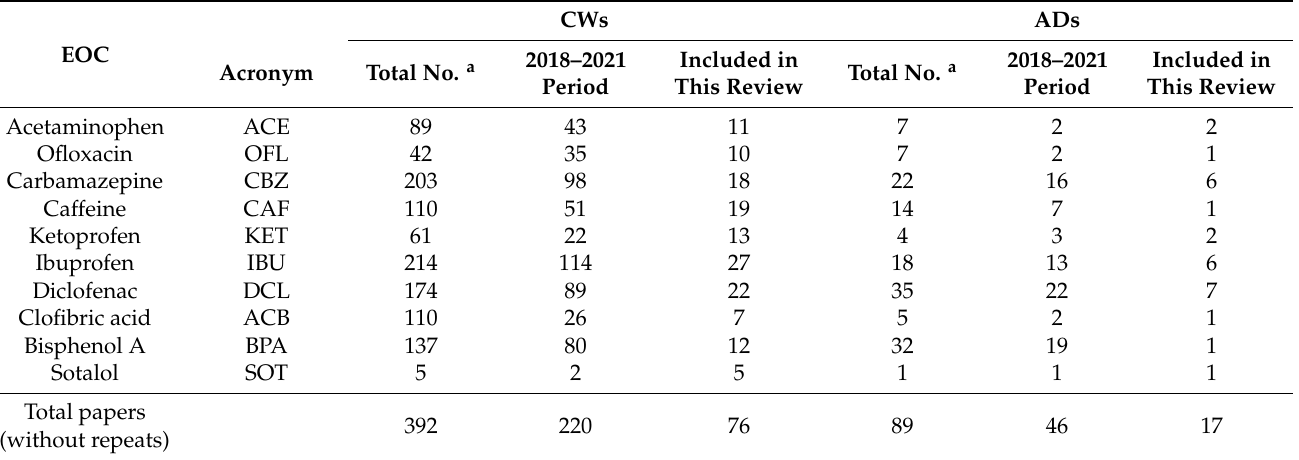
Table 1. Number of results obtained in the Scopus database until December 2021 dealing with each EOC in CWs and